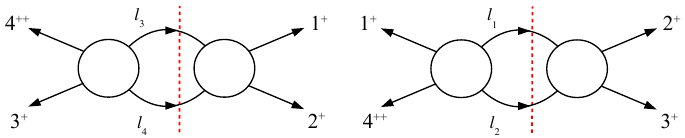
Figure 2 . The s - and t -channel cuts of the all-plus single-graviton amplitude. Cyclic permutations of the labels (1 ; 2 ; 3) should also be